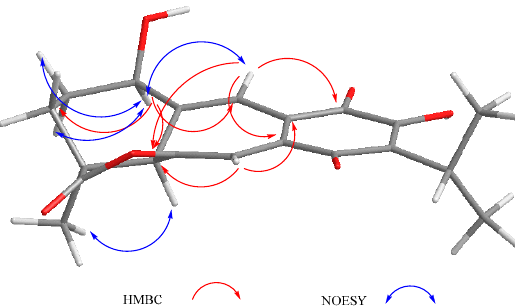
Figure 3. Selected correlations for compound 2 .